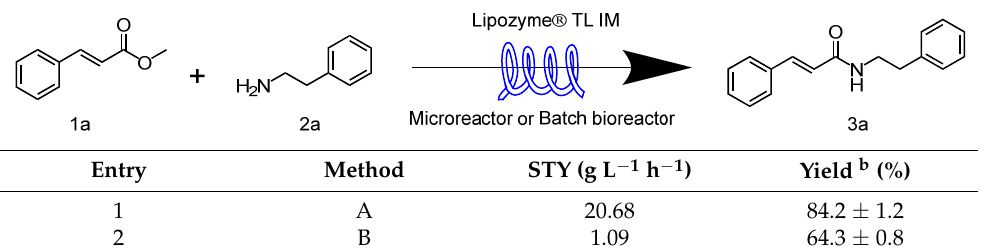
Table 2. Enzyme-catalyzed synthesis of N-phenethylcinnamamide in a Continuous-Flow Microreactor or a Batch Bioreactor a .